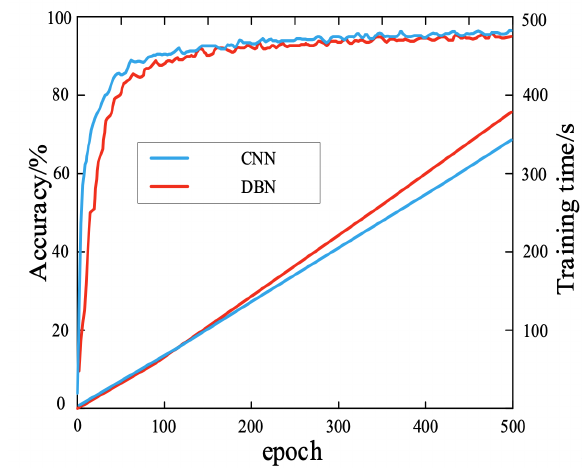
Fig. 11. The accuracy and training time of CNN and DBN model